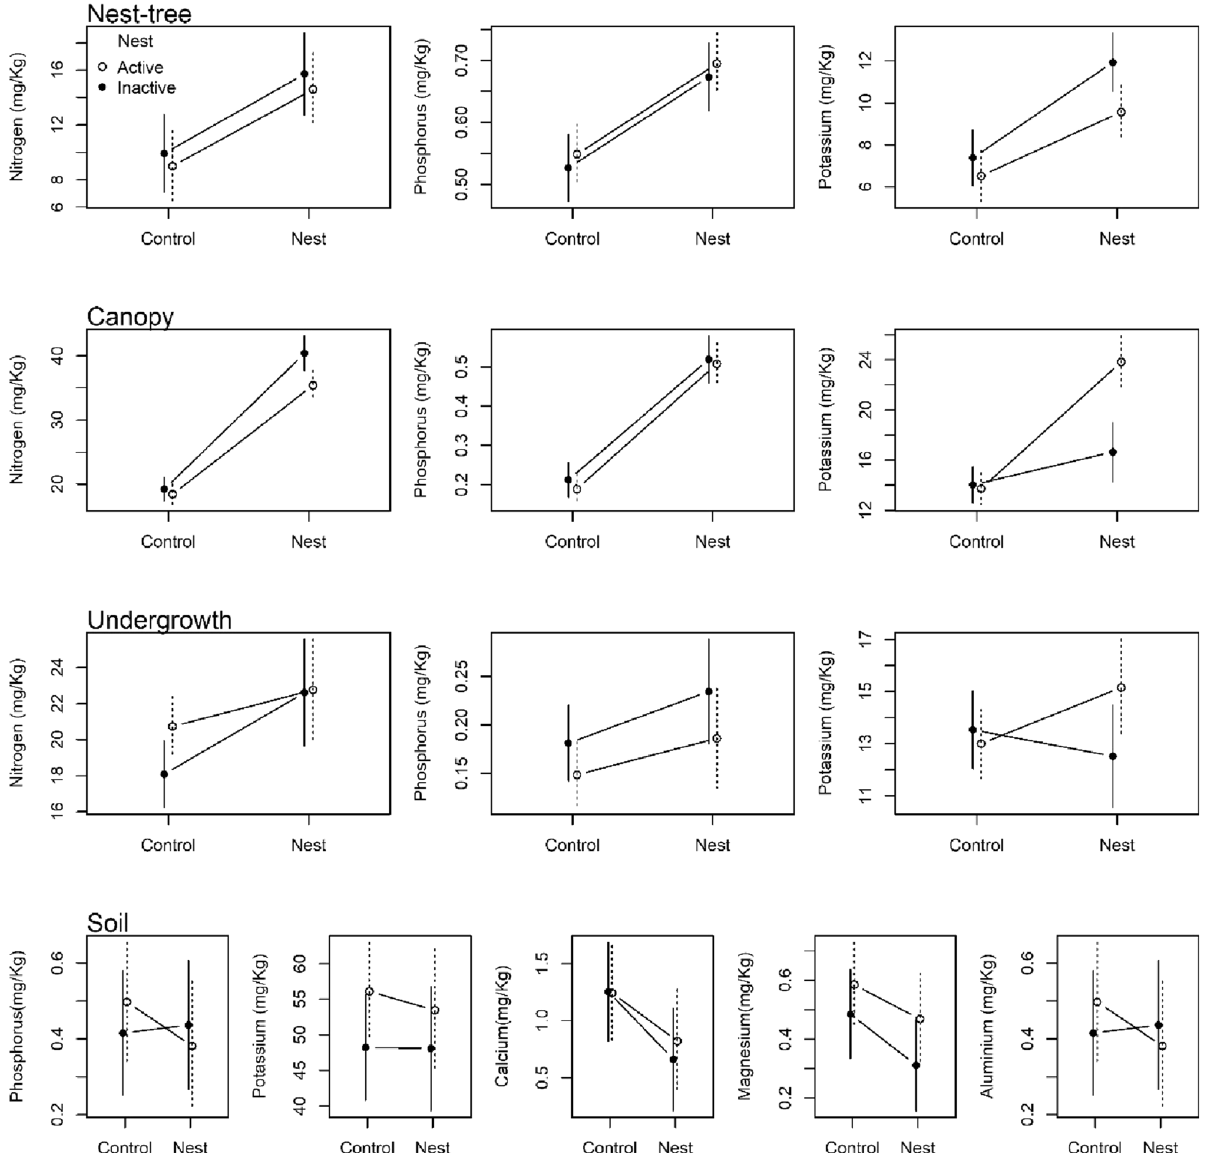
Figure 3. Effects of long-term presence of harpy eagle nests on the nutrient profile in both the soils and across the forest vertical stratification depending on nest activity (were white circles mean active and black circle mean